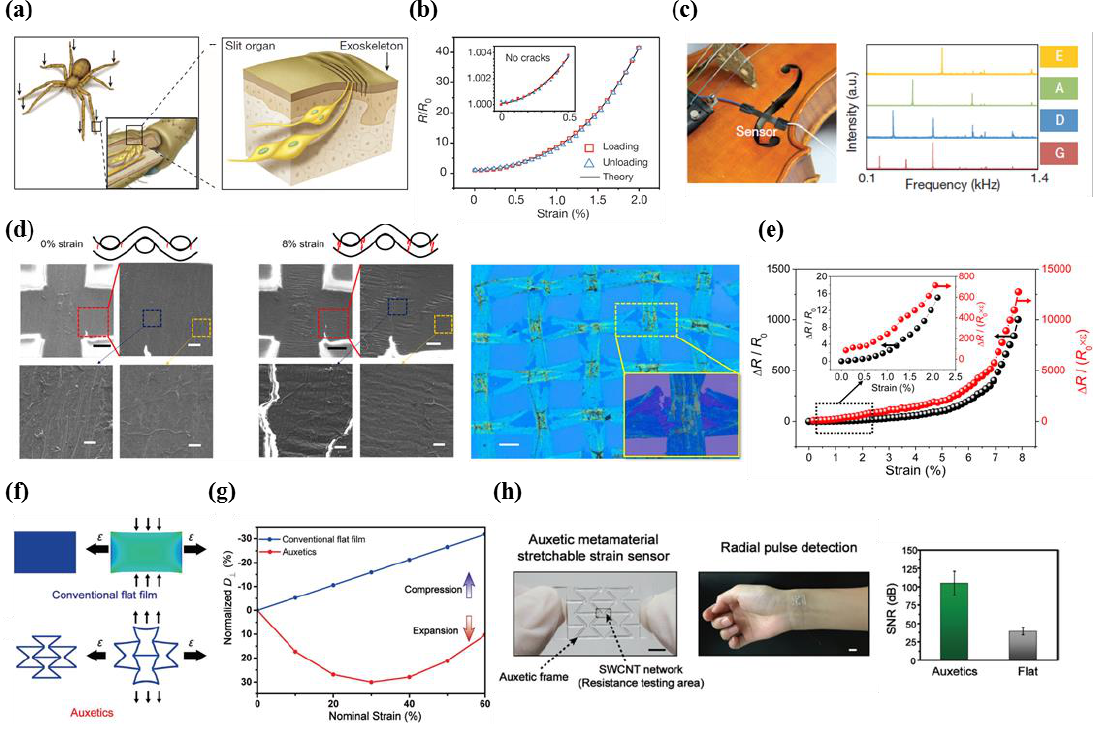
Figure 3. ( a ) Image of the special spider organ for detecting external stimuli (left) and the magnified image of the organ (right); ( b ) the relative output resistance change versus strain, including theoretical data; the inset shows the results of no cracks; ( c ) image of crack sensor onto violin for detection of sound wave (left). The intensity versus frequency, when Elgar’s ‘Salut d’Amour’ was played (right) (reprinted with permission for Figure 3a–c, from Ref. [20] Copyright 2014 Springer Nature); ( d ) SEM image shows the stretched graphene woven fabric (GWFs) depending on the strain (left). Optical image of the GWF on Si/SiO 2 substrate (right); ( e ) data showing the relative output resistance under different strain levels. (Reprinted with permission for Figure 3d,e from Ref. [22] Copyright 2015 American Chemical Society); ( f ) finite element modeling (FEM) simulation data including conventional flat film structure and auxetic metamaterial structure under 15% tensile strain; ( g ) the normalized displacement at the transverse direction under different levels of longitudinal tensile strain; ( h ) auxetic strain sensor and human wrist with sensor (left). The signal-to-noise ratio data in case of auxetics and flat sensors (right) (Reprinted with permission for Figure 3f–h from Ref. [40] Copyright 2018 John Wiley and Sons). Yang et al. described a graphene-based strain gauge sensor based on a crack mechanism